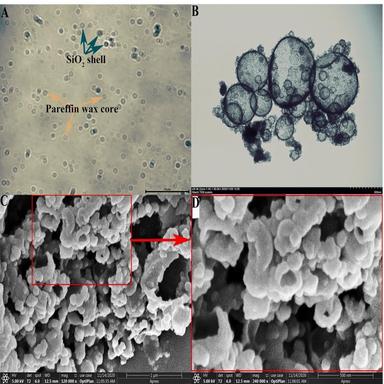
Microstructure images of the representative PS-5 measured by OM (A), TEM (B) and SEM (C, D).